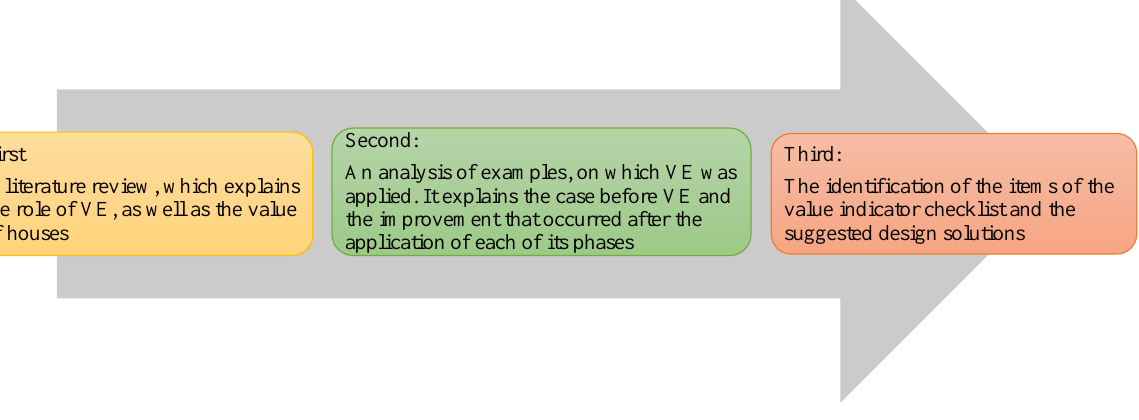
Figure 1. The structure of the paper and the methodology applied. Source: